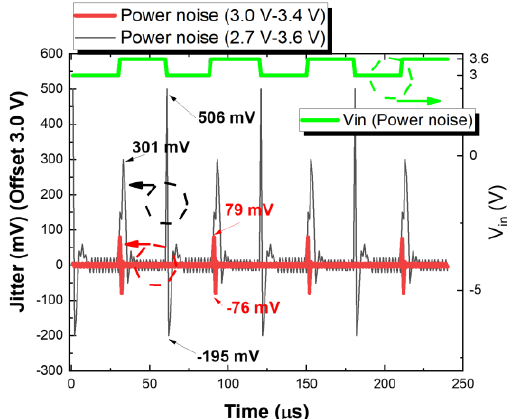
Figure 16. The measurement of output jitter from node V_M B of proposed low jitter low dropout regulator. The measured jitter is offset by 3.0 V. The jitters are investigated by power noise from 3.0 V to 3.4 V, and 2.7 V to 3.6 V.